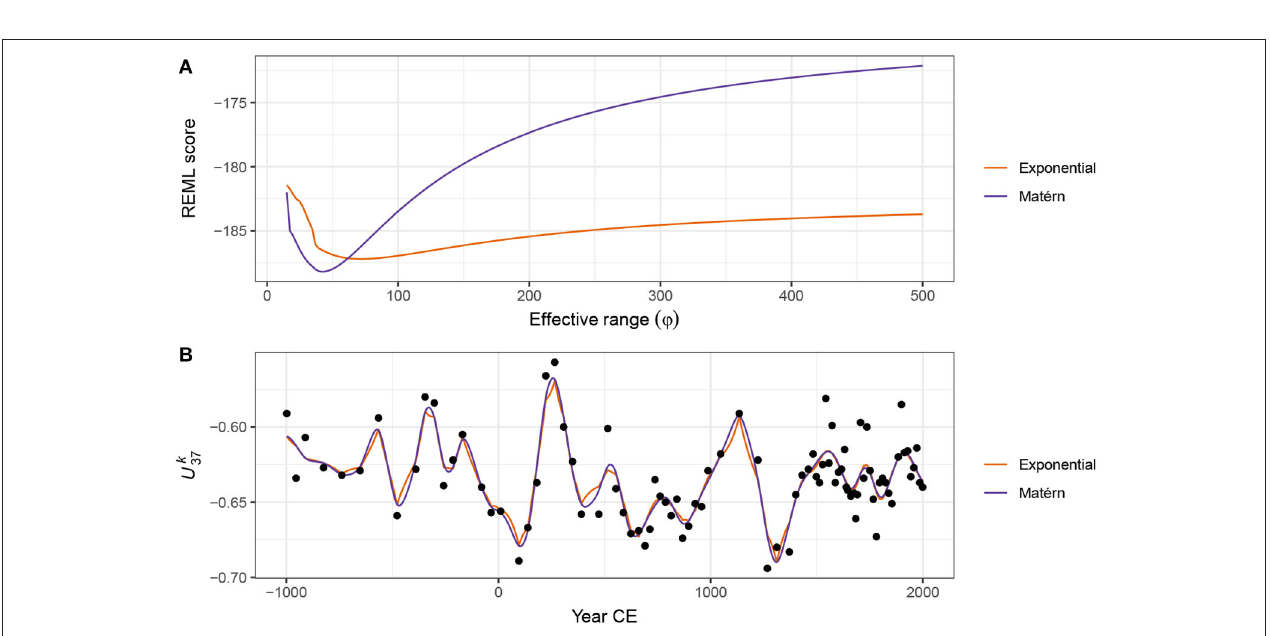
FIGURE 13 | Gaussian process smooths fitted to the U K 37 time series. REML score traces for GAMs fitted using power exponential ( κ = 1) or Matérn ( κ = 1.5) correlation functions as a function of the effective range parameter ( φ ) are shown (A) . The optimal model for each function is that with the lowest REML score. (B) Shows the resulting trends estimated using the respective correlation function with the value of φ set to the optimal